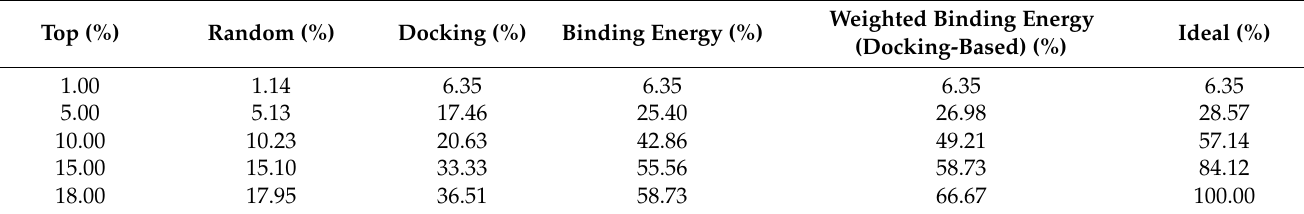
Figure 3. The validation of different methods for virtual screening. The black line is random module. The purple line is ideal module. The red line is pharmacophore docking module. The green line is the module of binding energy calculation from pharmacophore docked structure. The blue line is the module of weighted binding energy calculation from pharmacophore docked structure. Table 2. Hit rates of different docking methods used for virtual